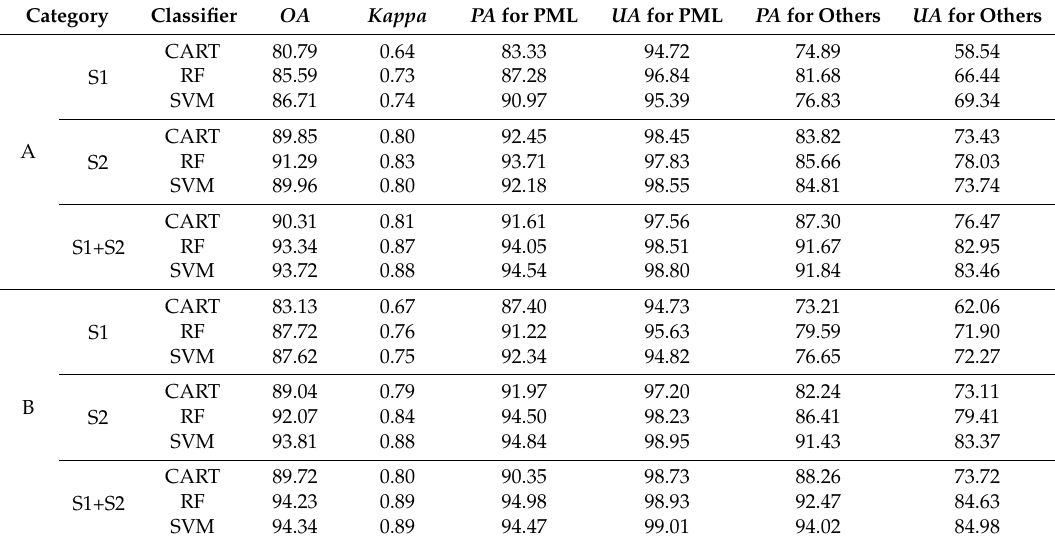
Table 3. Accuracy assessment for different classification strategies. (Category A. using spectral features and indices. Category B: using spectral features, indices, and textural features. OA : overall accuracy. PA : producer’s accuracy. UA : user’s accuracy. Kappa : Kappa